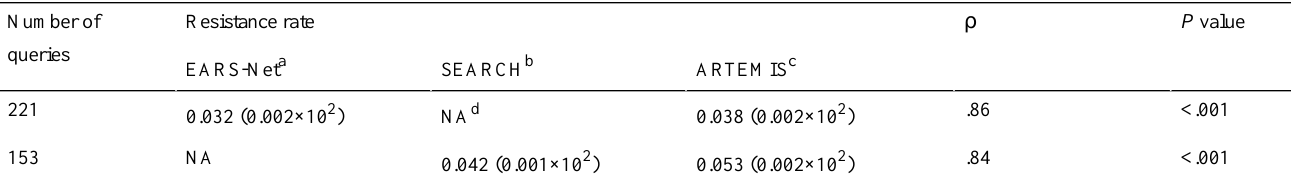
Table 3. Resistance rate geometric mean (SD) and correlation results.